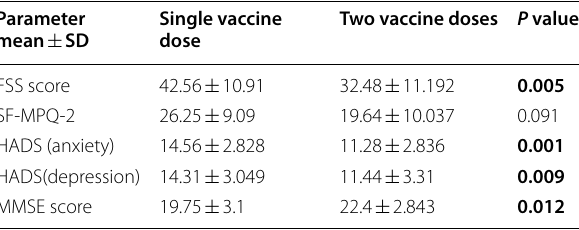
The used test was Kruskal–Wallis test. FSS fatigue severity scale, HADS hospital anxiety and depression scale, SF-MPQ-2 short-form McGill pain questionnaire, MMSE mini–mental state examination. Bold values are significant at P